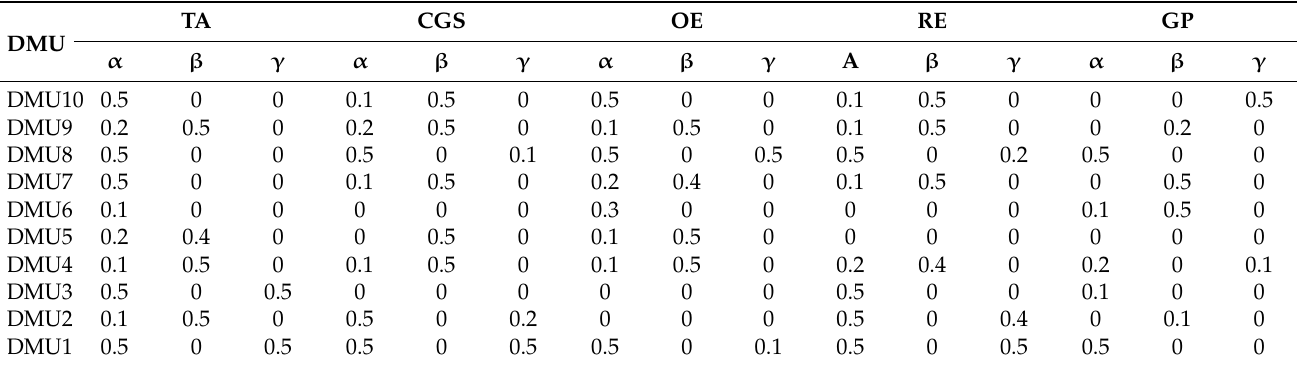
Table A3. Forecasting parameters of all DMUs from 2020 to 2023.